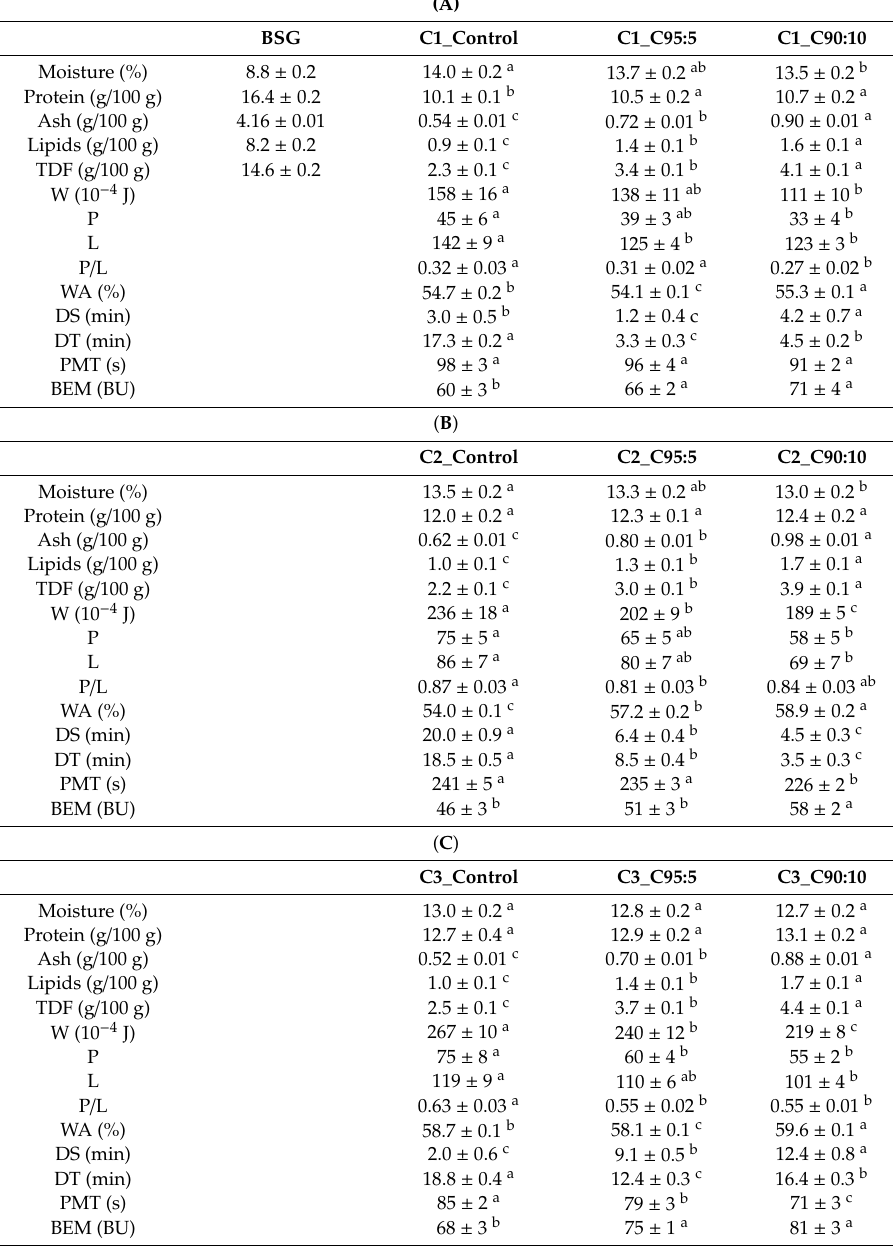
TDF = total dietary fiber; W = dough strength; P = dough tenacity; L = dough extensibility; P / L = configuration ratio; WA = water absorption; DS = dough stability; DT = development time; BEM = maximum torque; PMT = peak maximum time. Values with di ff erent superscript letters in the same parameter and sample are significantly di ff erent ( p <